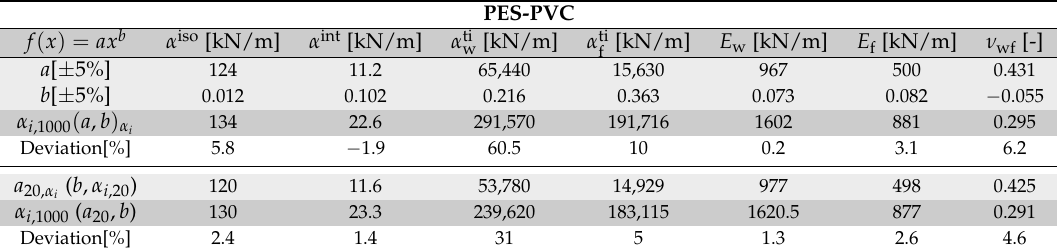
Table 6. Extrapolated material parameters and the computed coefficients of the estimation function using PES-PVC data. Deviation is computed as relative difference of an estimated parameter from its original value in Tables 4 and